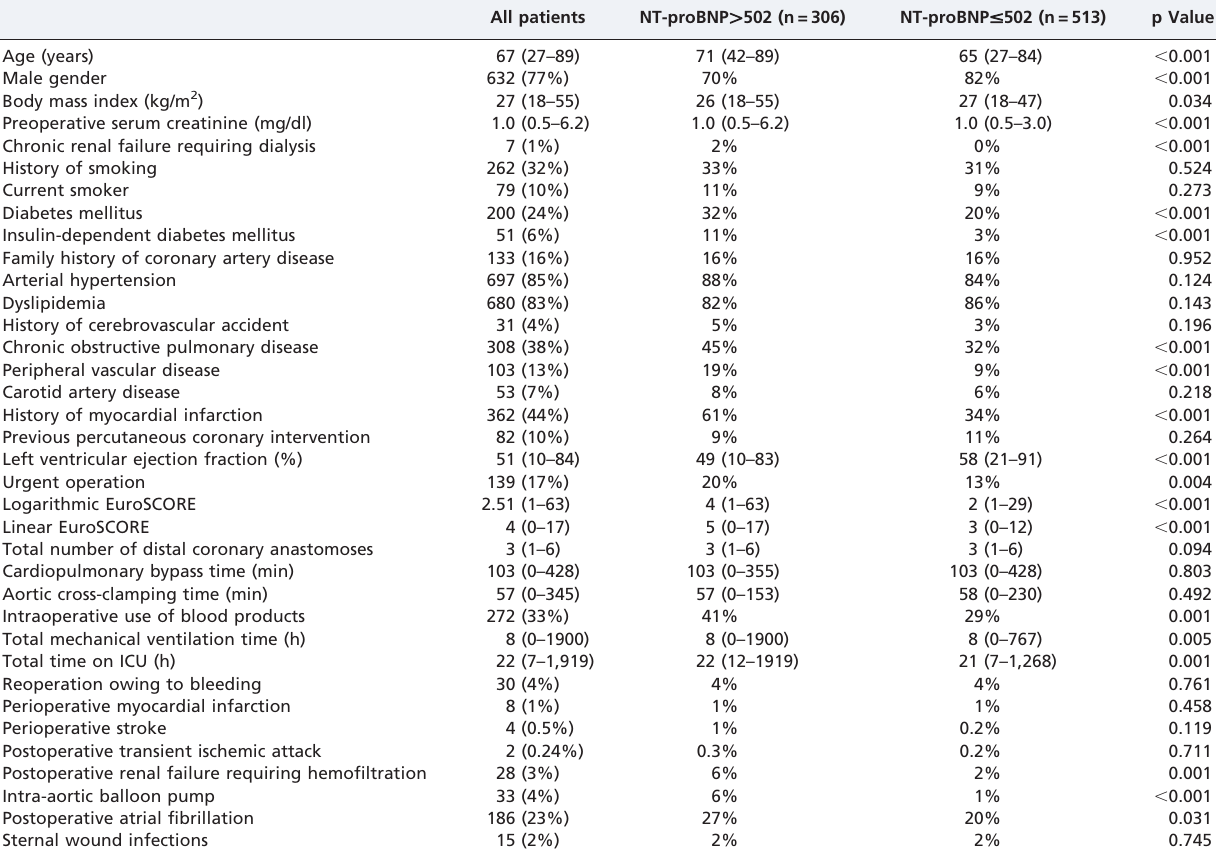
Table 4 - Demography of 819 isolated coronary artery bypass patients with preoperative evaluation of serum N-terminal pro-brain type natriuretic peptide (NT-proBNP)